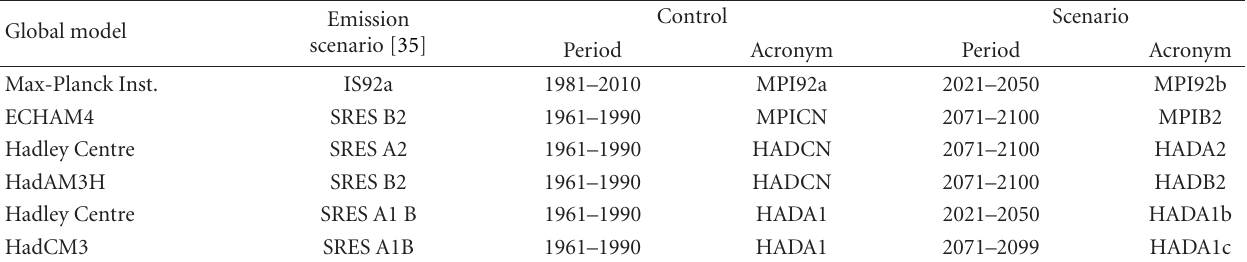
Figure 4: Projected changes from 1961–90 to 2071–2100 in (a) mean annual temperature ( ◦ C), (b) mean annual precipitation (%). The RCM projections are based on MPIB2 (cf. Table 5). Table 5: RCM simulations for the Svalbard region. The simulations were performed by the regional climate model HIRHAM2/NorACIA